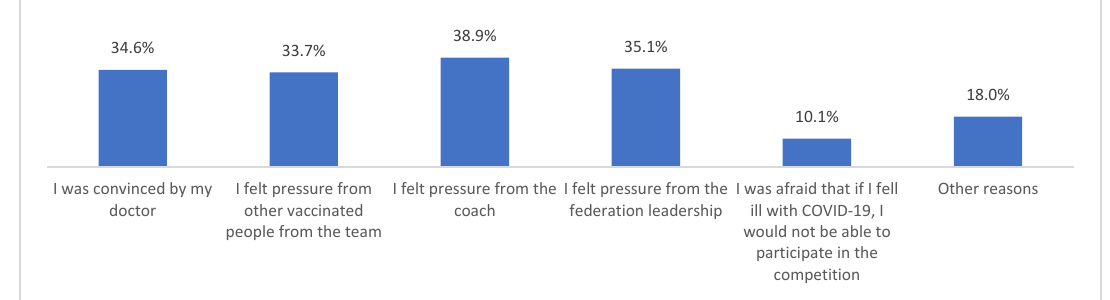
Figure 1. For what reason did you get vaccinated against COVID-19? ( n = 683). Multiple-choice responses were presented in the questionnaire only for those who declared that they had been vaccinated against COVID-19.